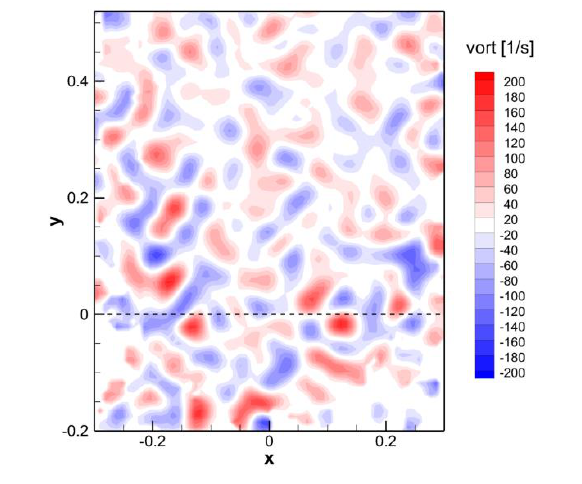
Fig. 6. Example of the instantaneous vorticity field. Re = 0.5M.